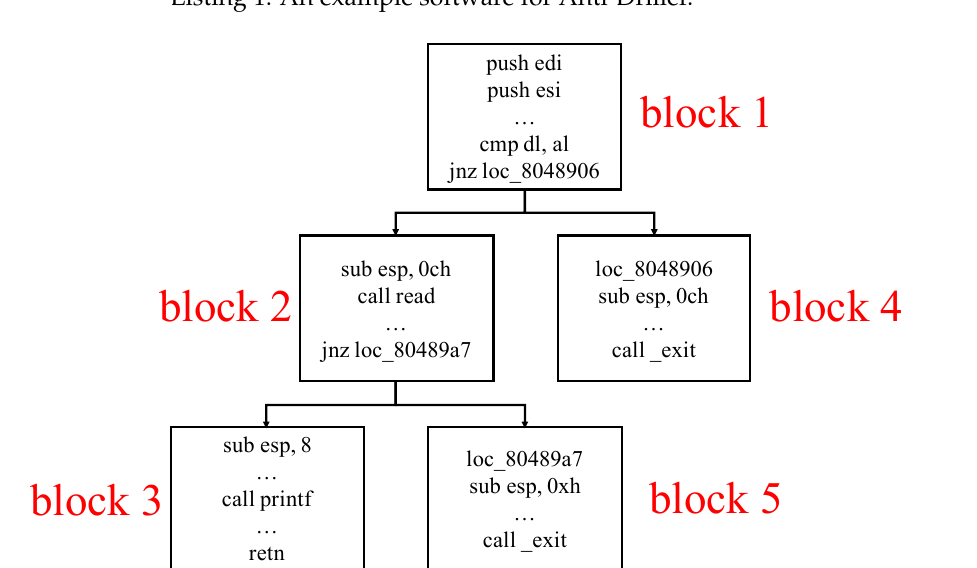
Figure 2. The control flow graph for Listing